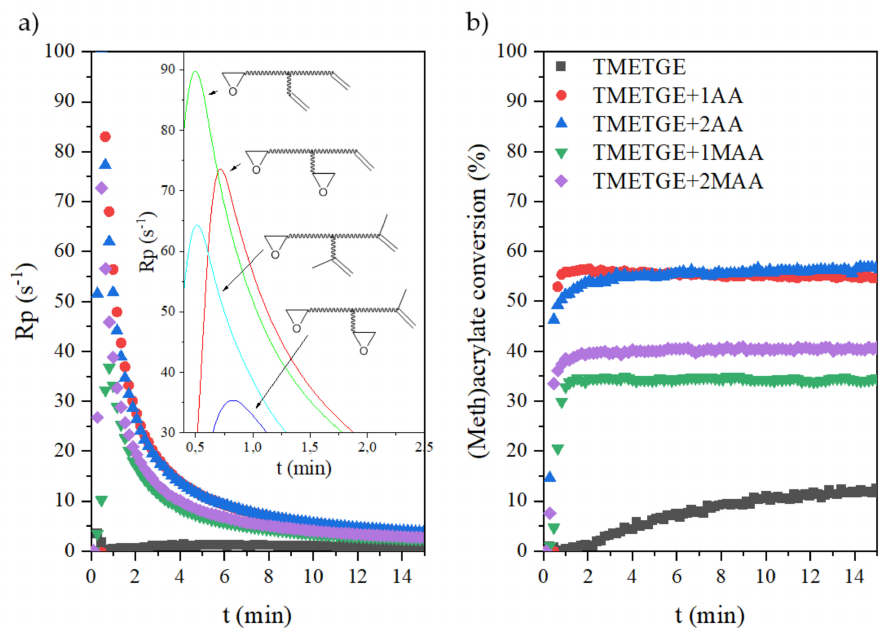
Figure 12. The photopolymerization rate ( a ) and the unsaturated double bond conversion ( b ) curves of the epoxy